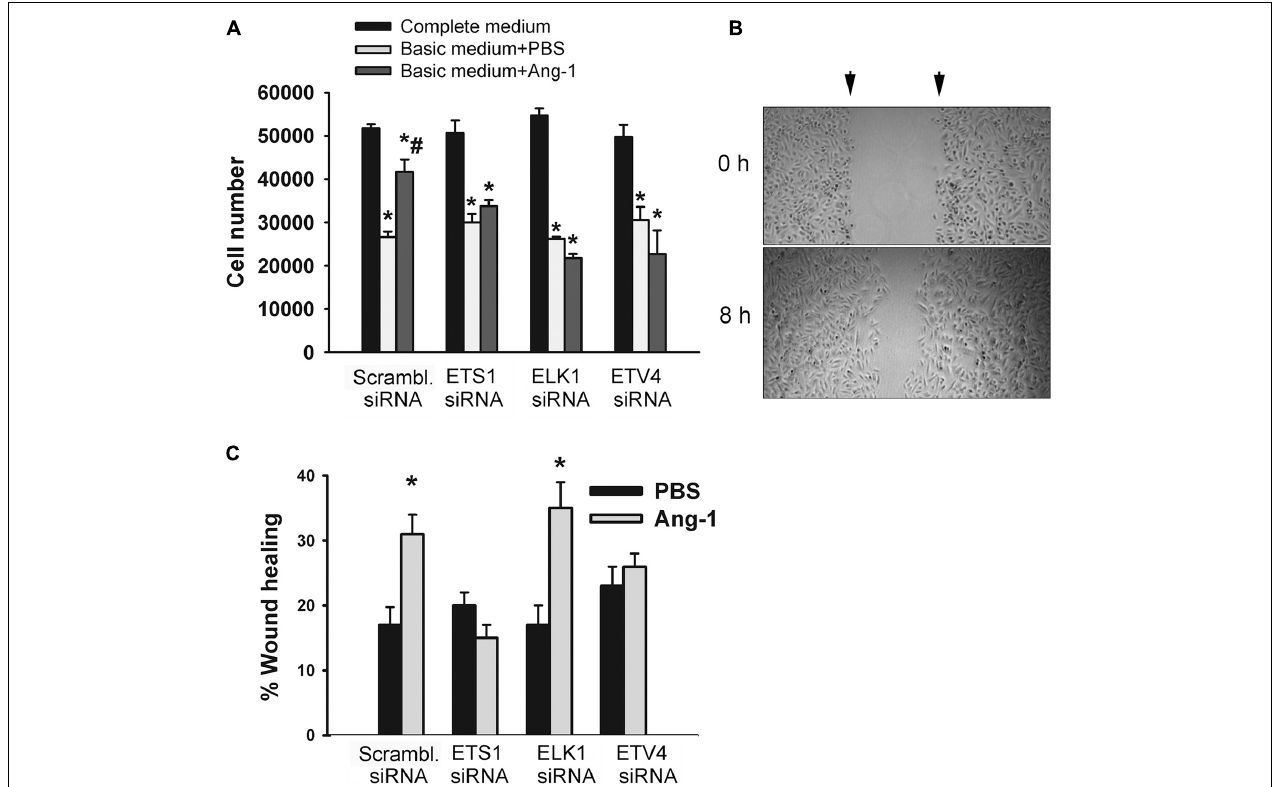
FIGURE 7 | ETS1, ELK1, and ETV4 contribute to Ang-1-induced EC survival and migration. (A) Cell counts of HUVECs transfected with scrambled, ETS1, ELK1, or ETV4 siRNA oligos. Equal numbers of cells were maintained in complete (20% FBS), basic medium (2% FBS) containing PBS, or Ang-1 (300 ng/ml). Cells counted 24 h later. Values are means ± SEM. * P < 0.05, compared to complete medium. # P < 0.05, compared to PBS. (B) Representative examples of scratch wound healing assays in HUVECs transfected with scrambled siRNA and maintained in basic medium containing Ang-1. Arrows indicate wound margins. (C) Scratch wound healing in HUVECs transfected with scrambled, ETS1, ELK1, or ETV4 siRNA oligos and maintained in basic medium containing PBS or Ang-1. Percent wound healing measured 8 h after wounding with pipette tip. Values are means ± SEM. * P < 0.05, compared to